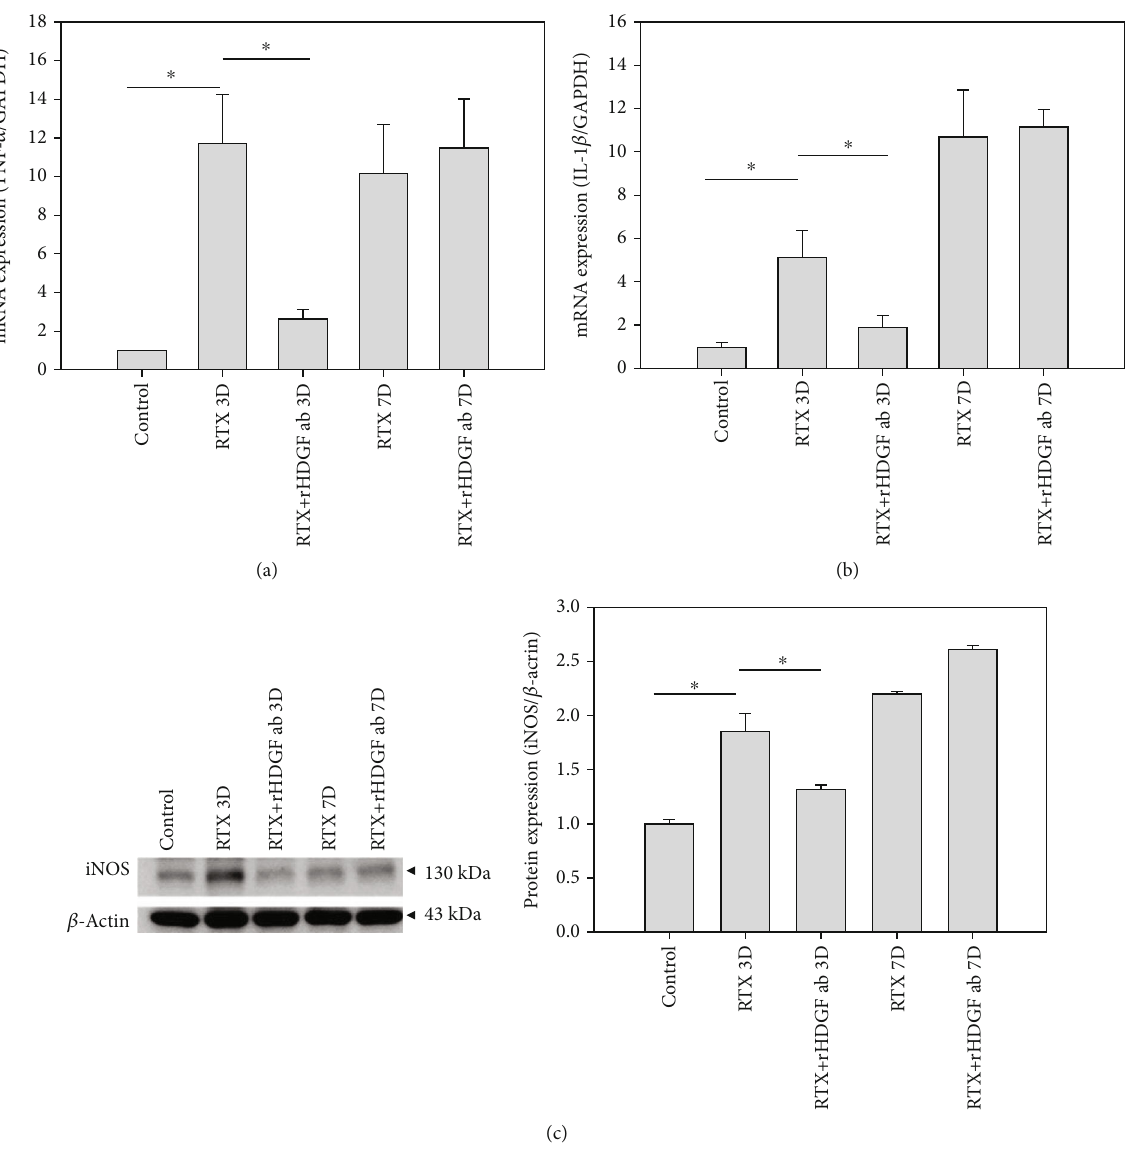
Figure 3: E ff ect of rHDGF antibody on in fl ammatory cytokines in RTX-treated rats. After the rats were divided into three groups, neuropathy was induced by intraperitoneally administration of a single dose of RTX (50 μ g/kg). In the RTX+rHDGF antibody group, 100 μ g/kg rHDGF antibody was administered and applied 24 hours before RTX injection. The control group received no rHDGF antibody pretreatment and no RTX injection. At 3 or 7 days after RTX injection and/or pretreated with rHDGF antibody, L3-L5 dorsal root ganglion and spinal cord dorsal horn were harvested. In fl ammatory cytokines were examined through RT-PCR or western blot analysis. (a) Gene expression of TNF- α and (b) IL-1 β in dorsal root ganglion of rats. Gene expressions are ratios relative to GAPDH. ∗ P < 0 : 05 . (c) iNOS expression in the spinal cord dorsal horn of rats. Representative Western blot results was shown. Expression levels were normalized to β -actin. ∗ P < 0 : 05 . Data are expressed as the mean + SEM ( n = 6 per